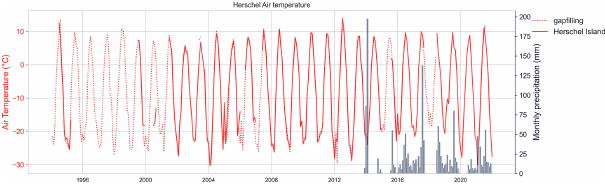
Figure A2. Comparison during 1994–2022 of air temperature mea- sured on Herschel Island and predicted value using the Burn and Zhang (2009)